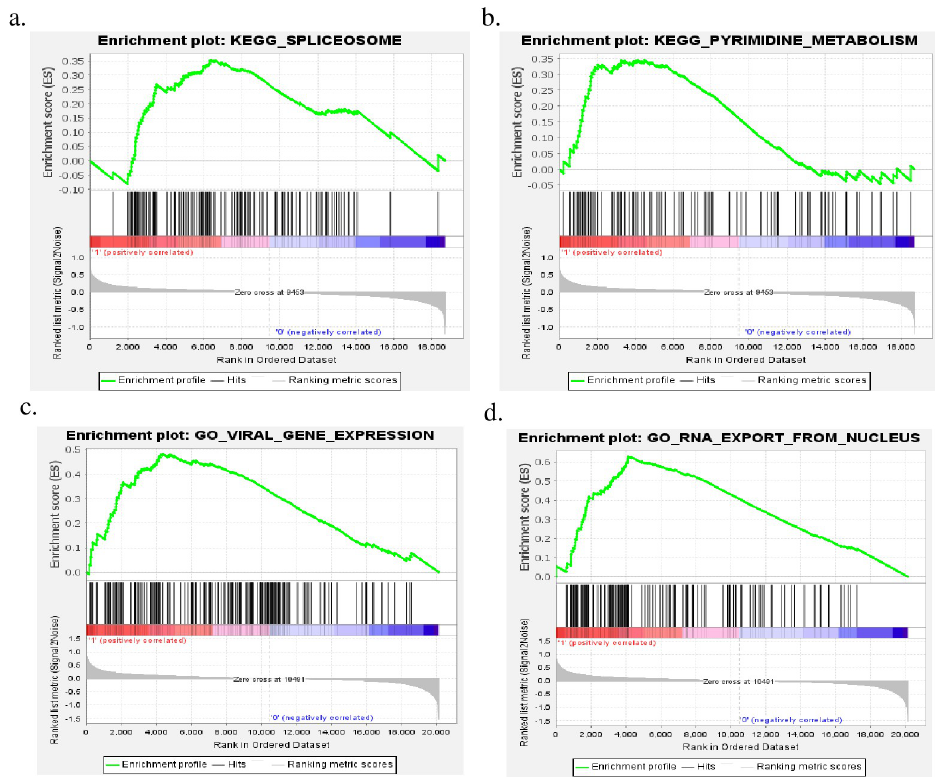
Fig 2. GSEA outcome of KEGG (a-b) and GO (c-d) with the largest absolute normalized enrichment size (NES).